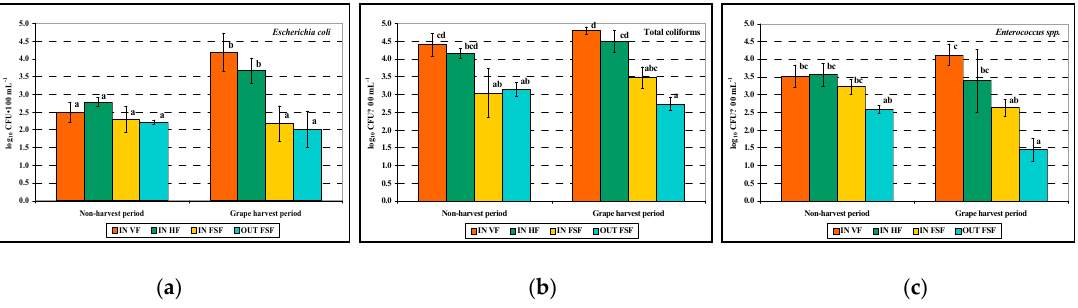
Figure 7. Average microbial counts ( ± SD) of Escherichia coli ( a ), total coliform ( b ), and Enterococcus spp . ( c ) detected in water samples collected in di ff erent CW units during rest and grape harvest periods. Di ff erent letters indicate significant di ff erences for p < 0.05 for the same plant species.